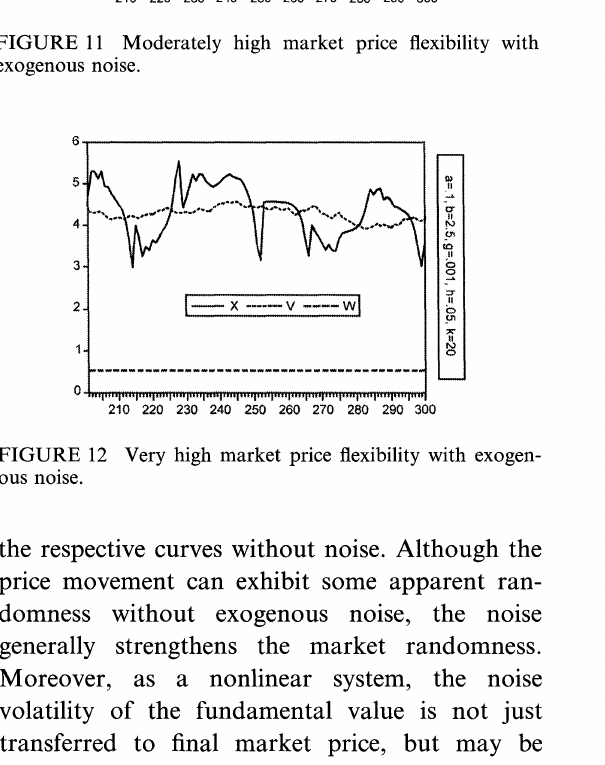
FIGURE 9 Low market price flexibility with exogenous noise.